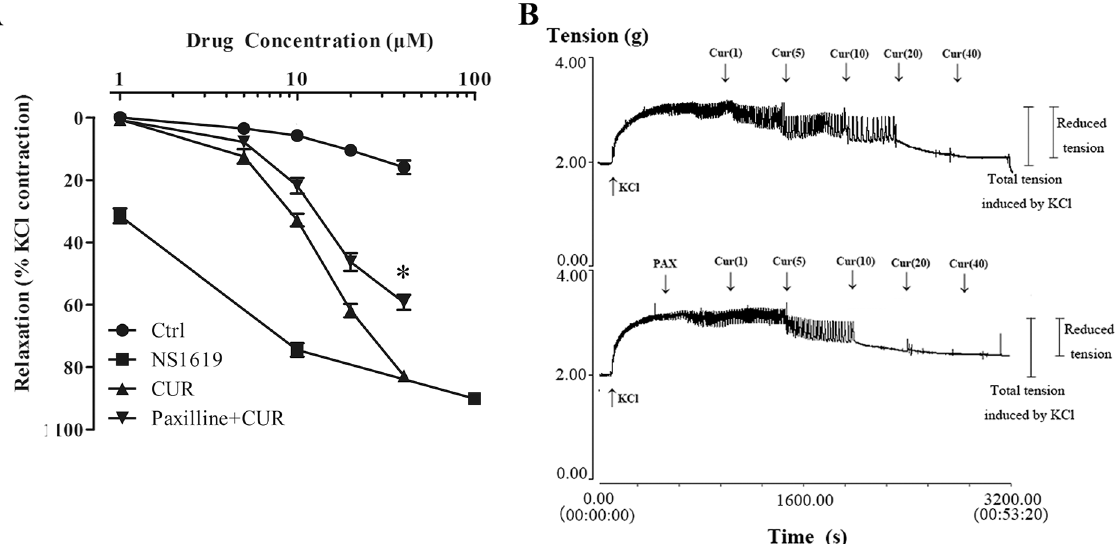
Fig 9. Effect of curcumin on the relaxation of the isolated rat aortic rings. (A) Concentration — response curves for the control, NS1619, curcumin (CUR) and paxalline (BK blocker) + CUR groups in the 20mM KCl-contracted arotic rings. Vasorelaxant effects are expressed as the percentage of the steady-state tension (100%) obtained with 20 mM KCl. Data points are presented as mean ± SE. (n = 4). * p < 0.05 compared to curcumin treatment alone. (B) Representative original traces of the vasorelaxant effects of curcumin, recorded on aortic rings precontracted with 20 mM KCl, in the absence or in the presence of paxilline. The curcumin was added cumulatively at the concentrations of 1, 5, 10, 20, 40 μ